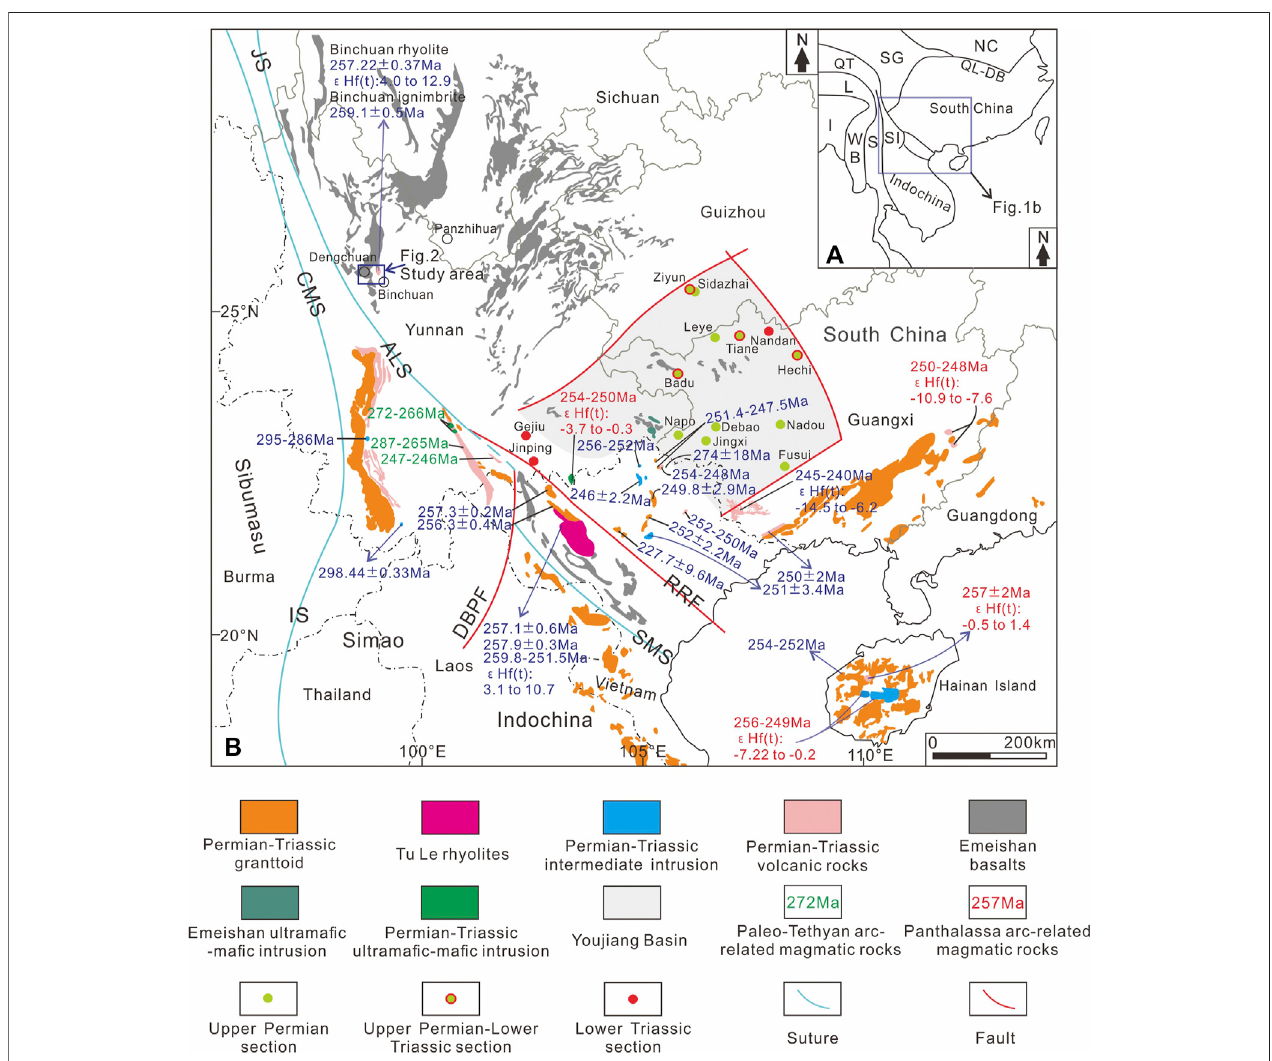
FIGURE 1 | (A) Tectonic outline of SE Asia (modi fi ed after Metcalfe, 2013; Wang et al., 2021). (B) Simpli fi ed geological map of the South China Craton and its adjacent regions showing the distribution of representative magmatic rocks (modi fi ed after Fan et al., 2008; Ali et al., 2010; Metcalfe, 2013; Yang et al., 2014; Hu et al., 2017; Shellnutt et al., 2020; Wang et al., 2021; Huang et al., 2022a). Data sources: Zhou et al. (2006); Hoa et al. (2008); Jian et al. (2009); Fan et al. (2010); Liu et al. (2011); Qing et al. (2011); Li et al. (2012); Chen et al. (2014); Lai et al. (2014); Zhong et al. (2014); Usuki et al. (2015); Halpin et al. (2016); Liu et al. (2017); Yan et al. (2017); He et al. (2018, 2020); Shen et al. (2018); Xu et al. (2018); Shellnutt et al. (2020); Tran et al. (2020); Gan et al. (2021); Wang et al. (2021); Huang et al. (2022a; and Huang et al. (2022b). NC: North China Craton, QL-DB: Qinling – Dabie Orogen, SG: Songpan-Ganzi Terrane, QT: Qiangtang, L: Lasha, I: India, WB: West Burma,